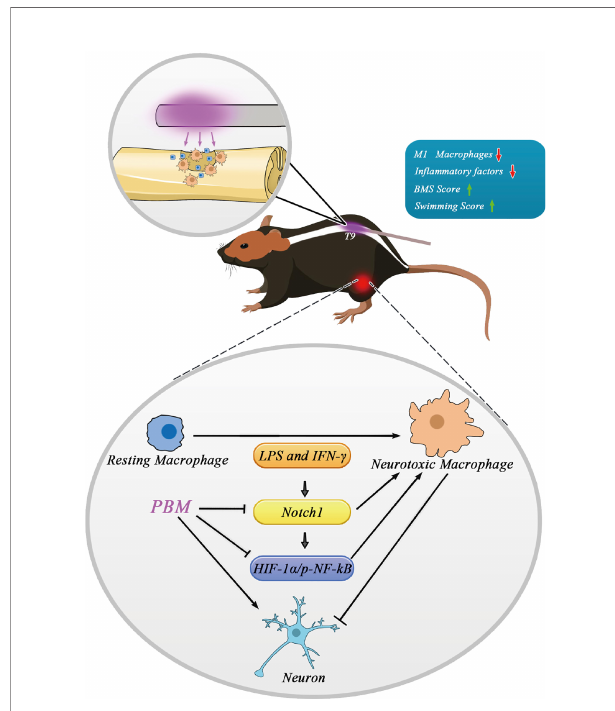
FIGURE 8 | Schematic model showing the regulatory role of PBM on M1 macrophages and its possible molecular mechanisms. Macrophages in the resting state become activated and are involved in neuroin fl ammation after spinal cord injury. Activated neurotoxic macrophages have damaging effects on neurons by secreting cytotoxic cytokines. The Notch1 and HIF-1 a /p-NF- k B axis are involved in macrophage activation. Speci fi cally, the Notch1 pathway is involved in the activation of neurotoxic macrophages and the expression of HIF-1 a and p-NF- k B. The neuroprotective mechanism of PBM may be related to its inhibition of the Notch1-HIF-1 a /p-NF- k B axis, which is associated with the activation of neurotoxic macrophage